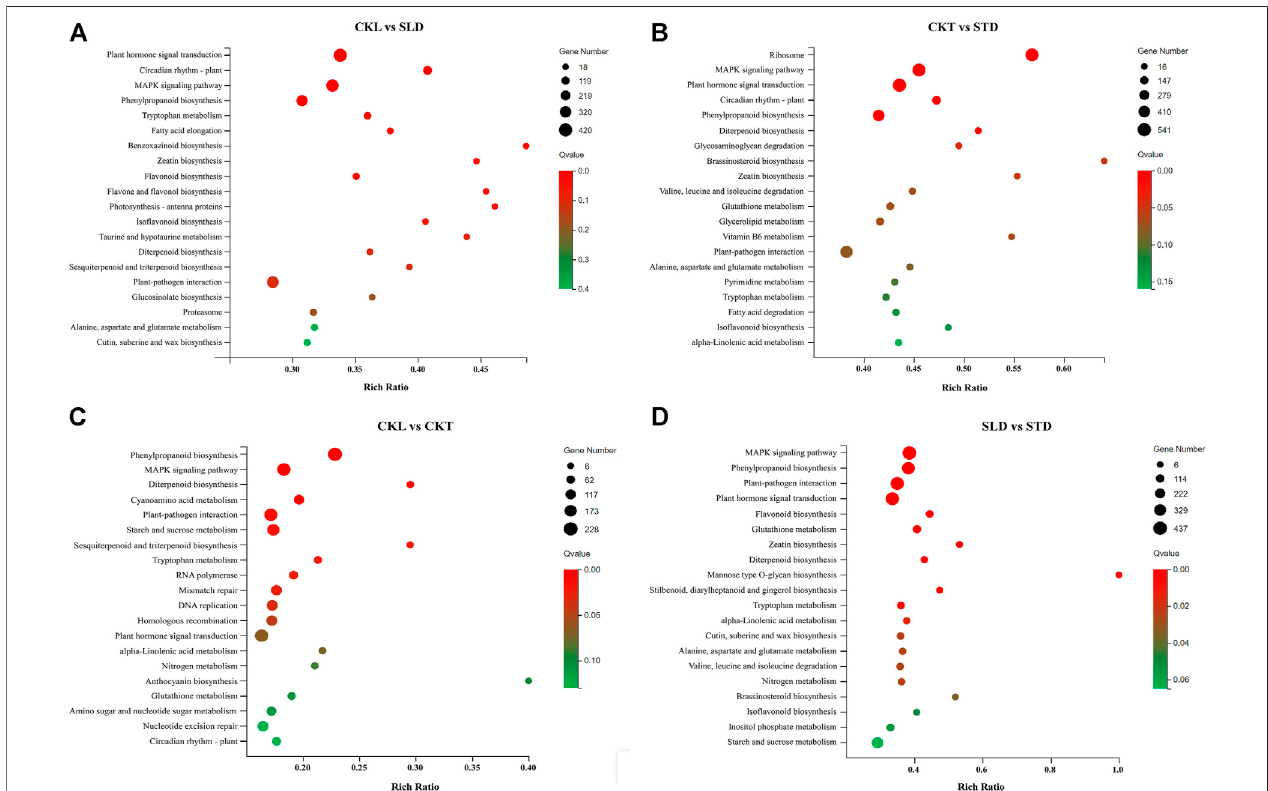
FIGURE4| KEGGpathwayenrichmentanalysisofDEGsin B.rapa underfreezingtreatments.TheKEGGmetabolicpathwayinCKL vs .SLD (A) ,CKT vs .STD (B) , CKL vs . CKT (C) , and SLD vs . STD (D)